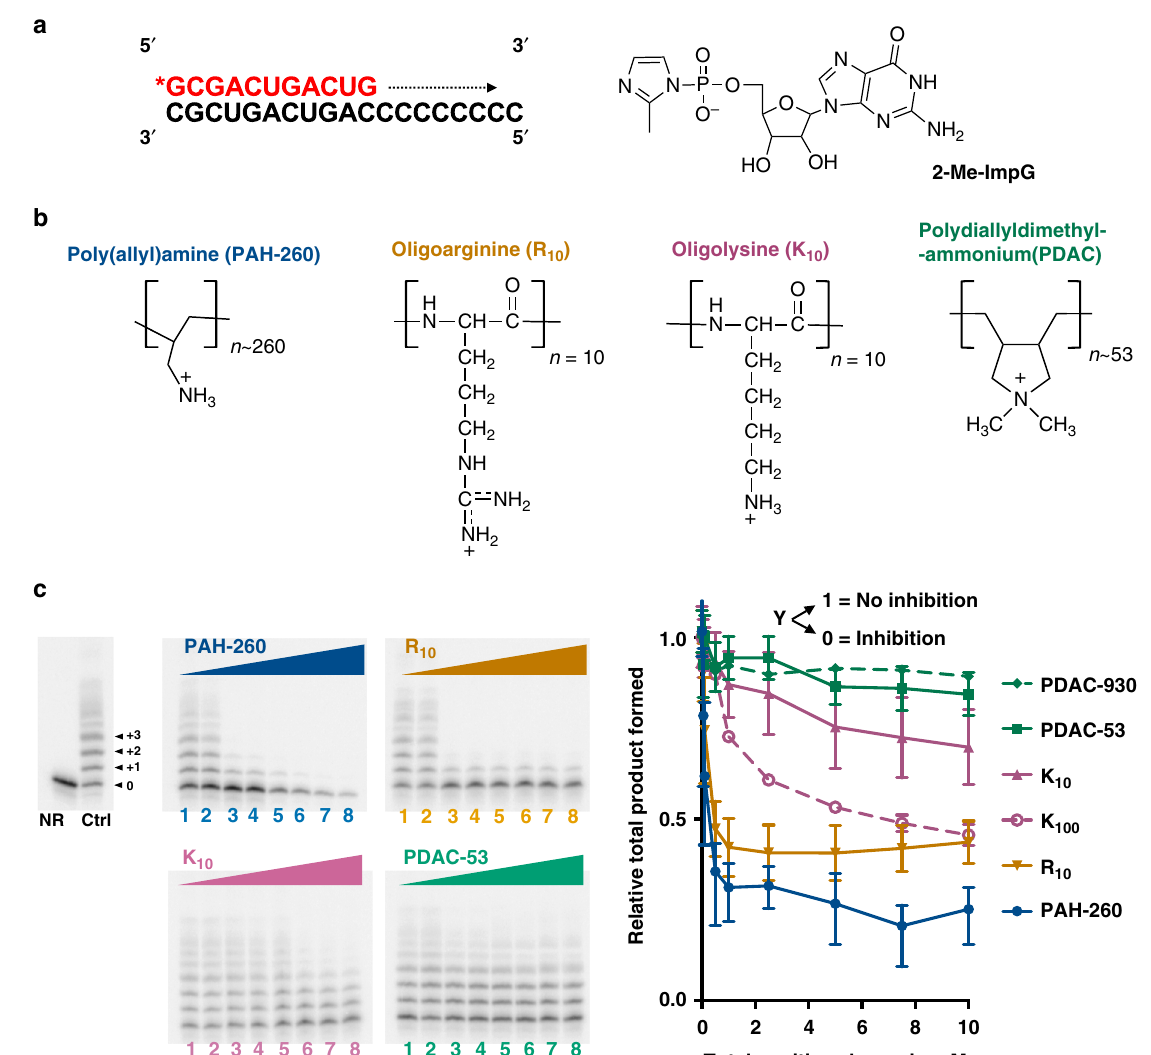
Fig. 1 Effect of polyamines on template-directed polymerization. a Primer (red)-template (black) complex used for template-directed polymerization using guanosine 5 ′ -(phosphor)-2-methylimidazolide (2-Me-ImpG). b Structures of polyamines used. c Representative denaturing polyacrylamide gel images show extension of 32 P-labeled primer. Lane Ctrl indicates reaction without any cationic polymer and NR indicates no reaction in the absence of monomer, lanes 1 – 8 contain 0.050, 0.10, 0.50, 1.0, 2.5, 5.0, 7.5, and 10 mM total positive charge from PAH-260 (blue), R 10 (orange), K 10 (dark pink), and PDAC-53 (green). Reactions were carried out for 5 h and contained < 50 nM 5 ʹ -end-labeled primer and 1 µ M template in 25 mM Tris – HCl pH 8.0 and 5 mM MgCl 2 . Fraction converted to product was normalized to the yield in the absence of any cation ctrl. Error bars represent S.E.M. from three independent experiments. Uncropped gel images are shown in Supplementary Figure